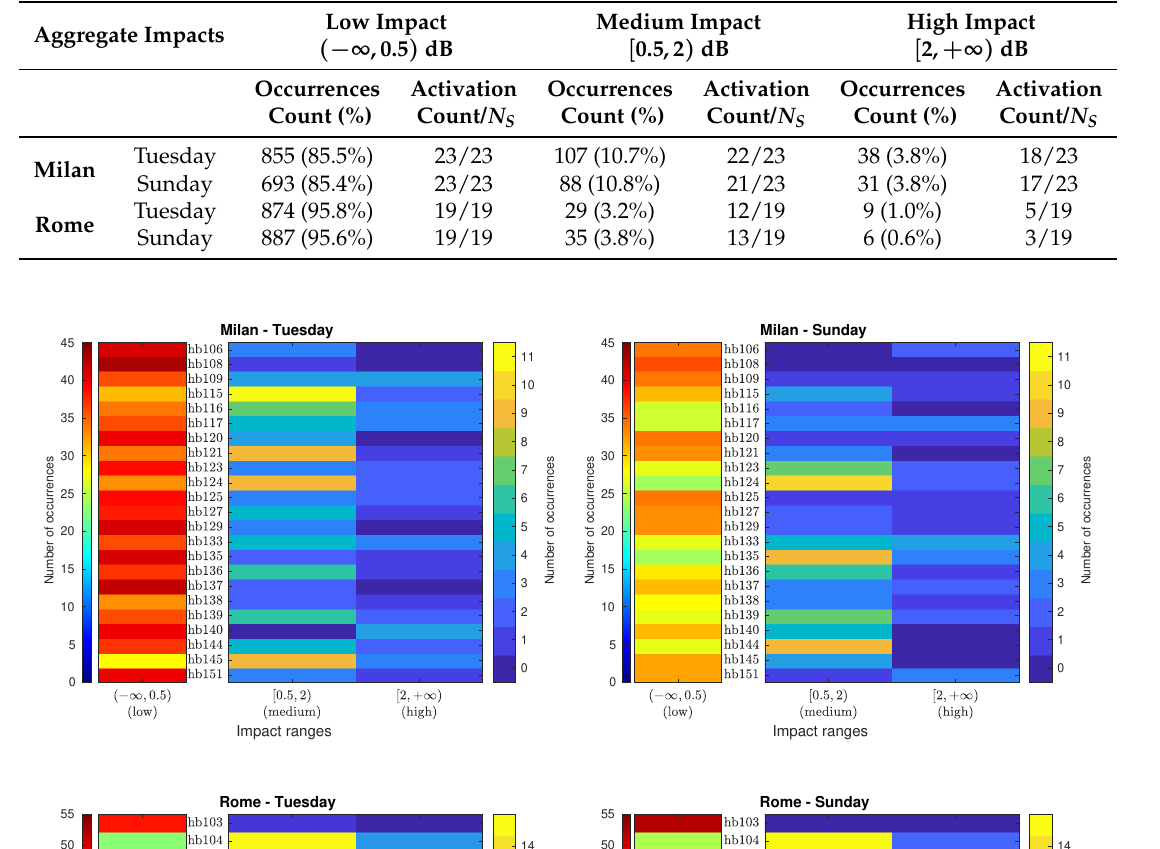
Table 4. Number of occurrences and sensor activation ratios per sensor for low, medium and high aggregate impact ranges.